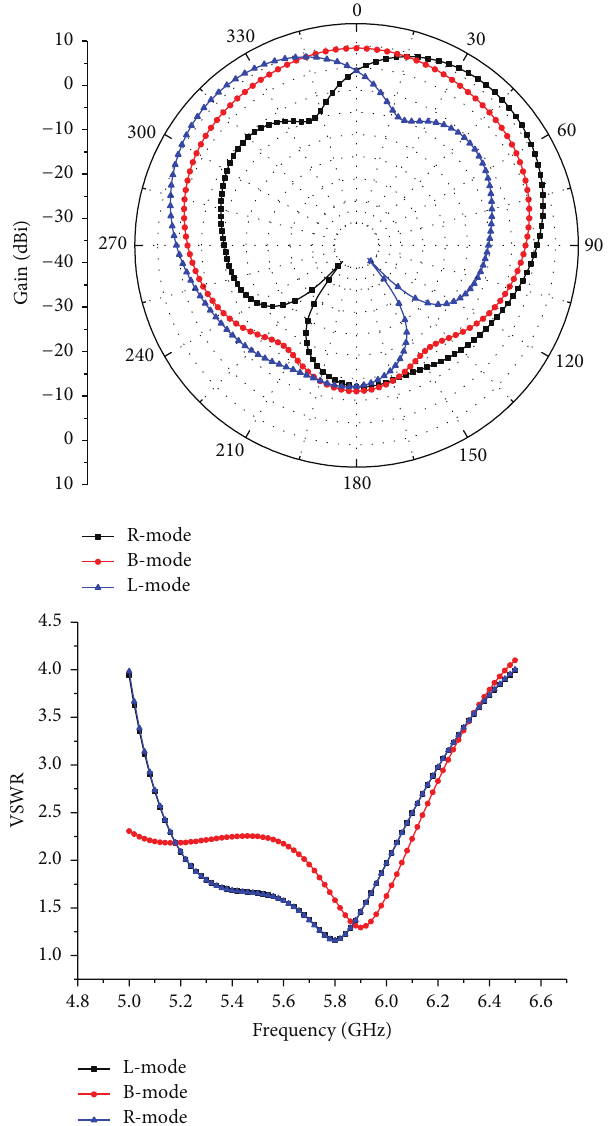
Figure 3: Radiation pattern and VSWR of the proposed antenna.